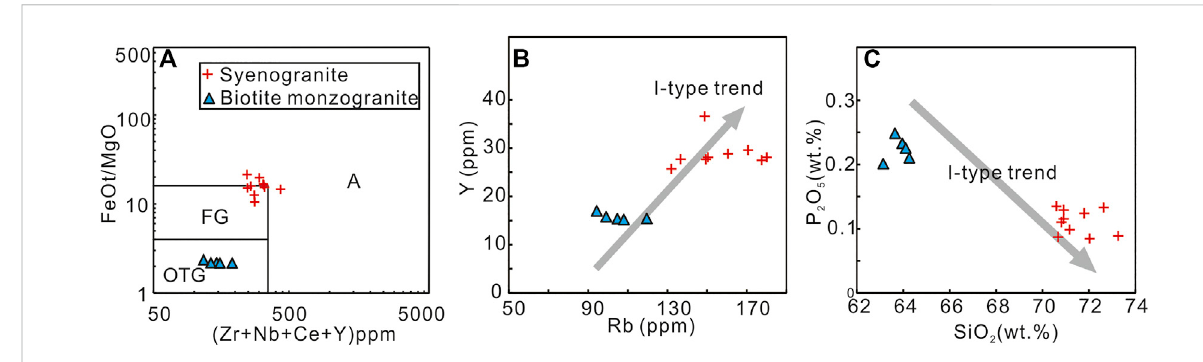
FIGURE 9 (A) K 2 O/MgO versus 10000Ga/Al (Whalen et al., 1987); (B) Y versus Rb diagrams; (C) P 2 O 5 versus SiO 2 diagrams. Abbreviations: FG – highly fractionated I-type granites; OTG – undifferentiated I, S, M-type granites.